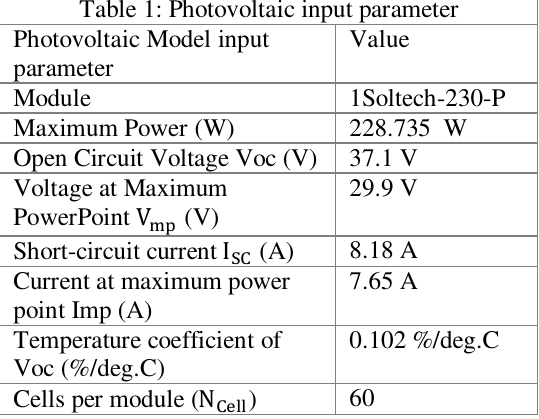
Table 1: Photovoltaic input